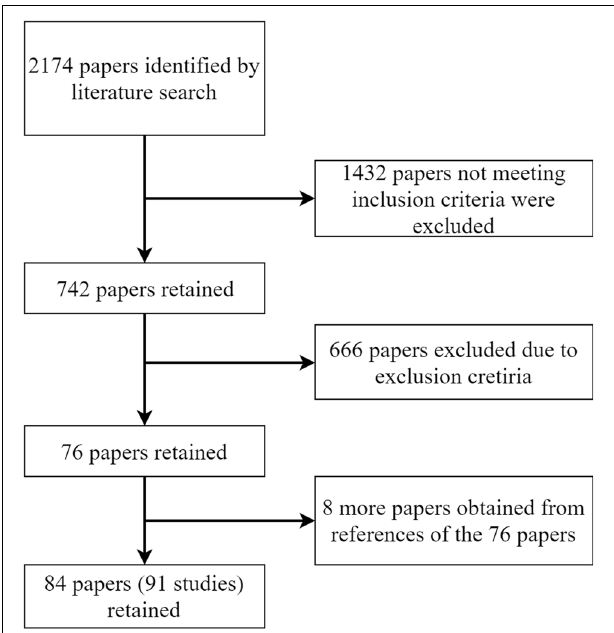
FIGURE 1 | Flowchart for the inclusion of published data for the current meta-analysis.